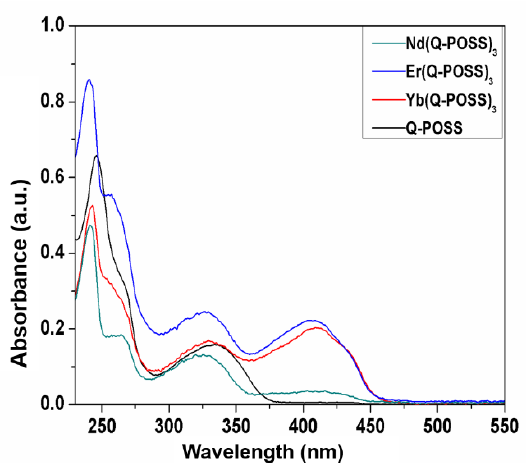
Figure 2. UV–Vis absorption spectra of Q-POSS, Er(Q-POSS) 3 , Nd(Q-POSS) 3 , and Yb(Q-POSS) 3 in dichloromethane solutions (1 × 10 − 5 M) at room temperature.